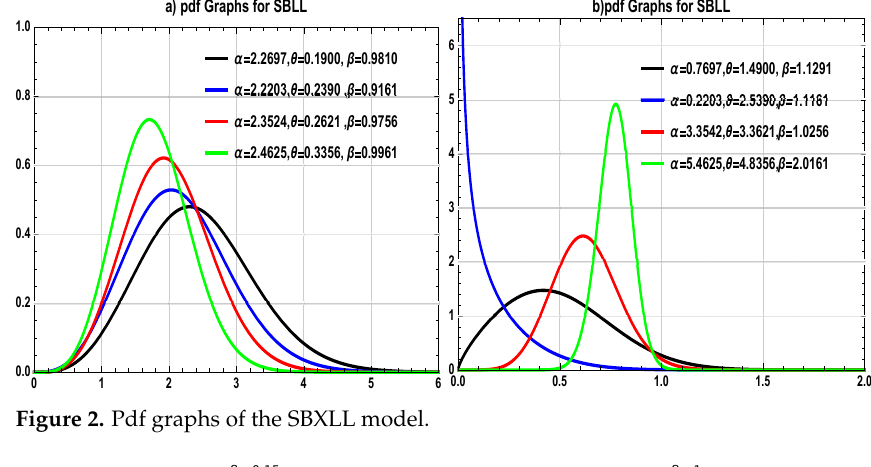
Figure 2. Pdf graphs of the SBXLL model.